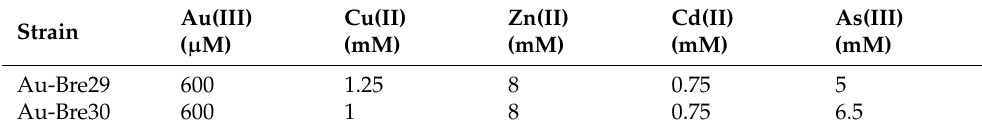
Table 3. MICs of strains Au-Bre29 and Au-Bre30 for selected heavy